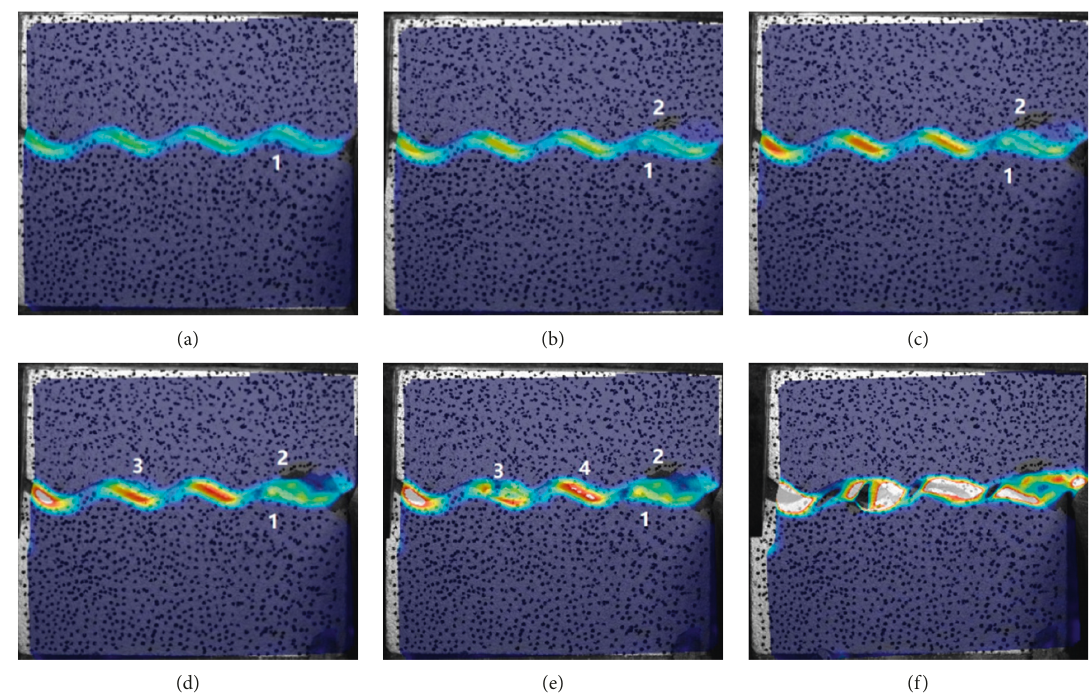
Figure 7: Failure process of the specimen with an undulated height of 5mm under DIC